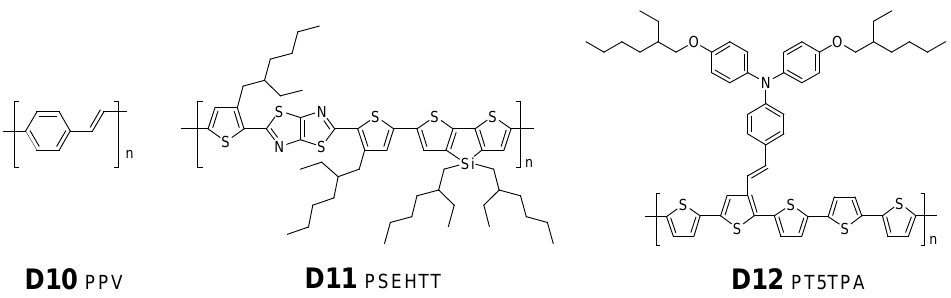
Figure 5. Molecular structures of polymer donors ( D10–D12